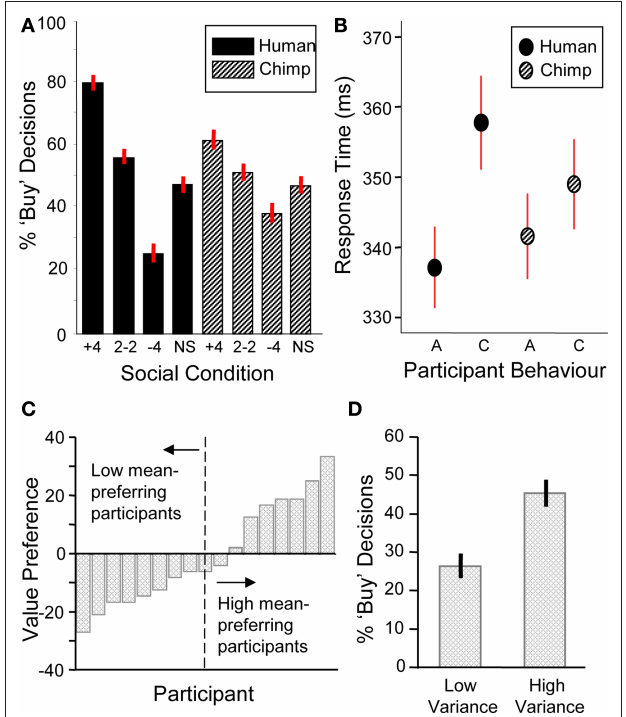
Figure 2 | Behavioral data ( n = 17). (A) Participants were sensitive to social information (one-way ANOVA, F (3,17) = 67.14, p < 0.001) and choice behavior was modulated significantly more by human social information (two-way ANOVA, F (3,17) = 9.95, p < 0.001). (B) Response time data. Participants had significantly longer response times for contrarian decisions ‘C’ than aligning decisions ‘A’ during human information trials (student’s t -test, t = 1.86, p < 0.05). There was no significant difference for chimpanzee information trials (student’s t -test, t = 0.84, p = 0.40). (C) Behavioral stock value preference for each participant (arranged in ascending order of mean preference). The individual stock value preference was calculated by subtracting the percentage of buy decisions for the low mean stock from the percentage of buy decisions for the high mean stock. A median split of the participants produced high and low mean-preferring groups used in subsequent mean preference contrasts. (D) Behavioral preferences for stock variance. Participants chose the high variance stocks more often than low variance stocks (student’s t -test, t = 4.1, p <